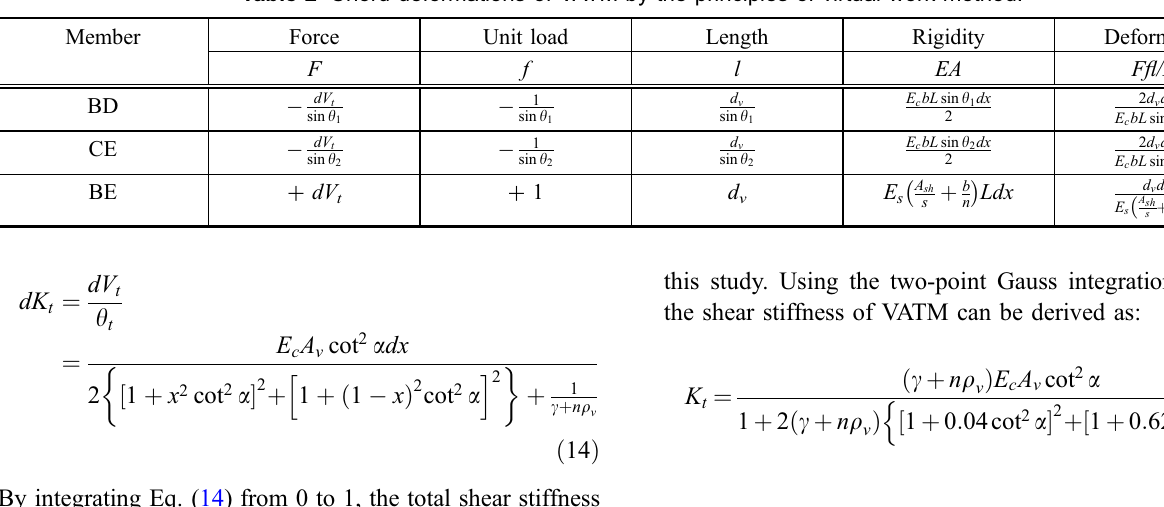
Table 2 Chord deformations of VATM by the principles of virtual work